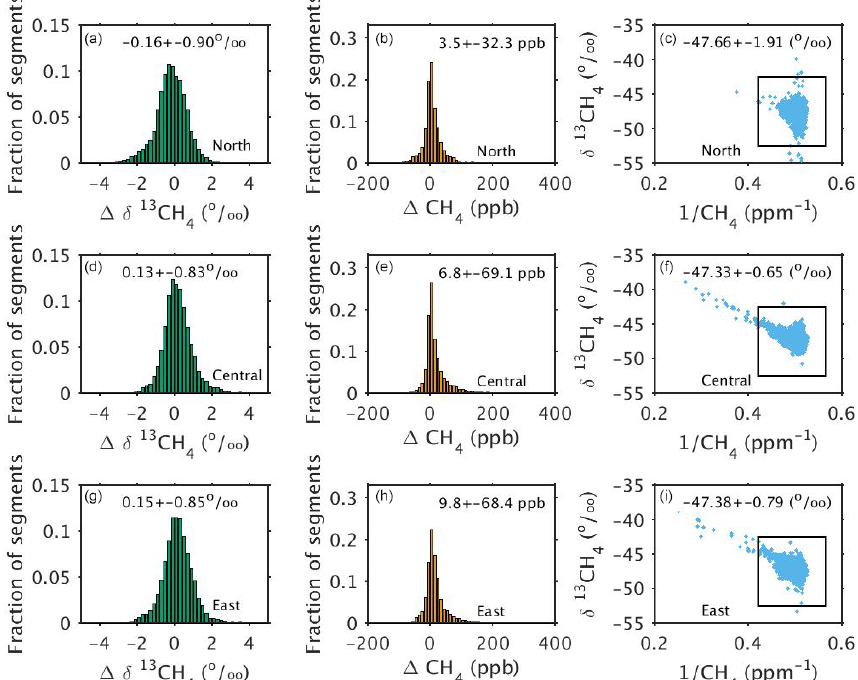
Figure 15. Probability distribution function of measured isotopic ratio differences from the background south tower ( (cid:49)δ 13 CH 4 ) for the (a) north, (d) central, and (g) east towers for all times of data excluding the afternoon hours shown in Fig. 14. The averaging interval of the individual data points for all plots is 10min, and the time period is January–May 2016. The bin size for (a) , (d) , and (g) is 0.2‰. The median and standard deviation of the differences are indicated on the plots. Probability distribution function of methane mole fraction enhancements ( (cid:49) CH 4 ) for the (b) north, (e) central, and (h) east towers. Note that the scale for (b) , (e) , and (h) has been truncated to focus on majority of the data points. The bin size is 10ppb CH 4 . Keeling plots for the (c) north, (f) central, and (i) east towers. The black box in each plot indicates the approximate scale of the corresponding isotopic ratio difference and methane mole fraction enhancement plots. The median and standard deviation of the isotopic ratios at each tower are indicated on the plots. Note that the Allan deviation for 10min means at ambient mole fractions was 0.4‰, and this decreases with increasing mole fraction.